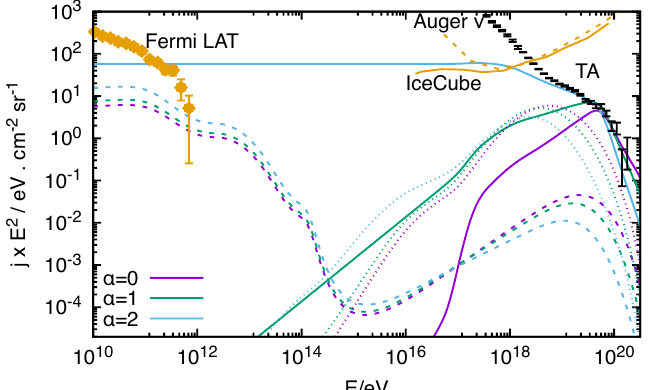
Figure 2. Highest primary proton spectrum allowed by the criterion in Equation (2) (solid lines), and secondary photon (dashed lines) and all flavor neutrino (doted lines) spectra produced in the model of Figure 1, but for different values power law index α ( α = 0, 1, and 2 in magenta, green, and sky blue, respectively). The lower radio background model of [44] is used, multiplied by F rad = 0.1 (as in Figure 1). The isotropic diffuse photon flux measured by Fermi LAT [38], shown in ochre, almost constrains the α = 2 model as much as the limit in Equation (2) and is much above the predicted flux for the other two. The upper bounds on all flavor neutrino diffuse flux by IceCube and Auger [39], shown in ochre, do not constrain any of the models. The figure shows that the model of Figure 1 predicts the highest level of GZK